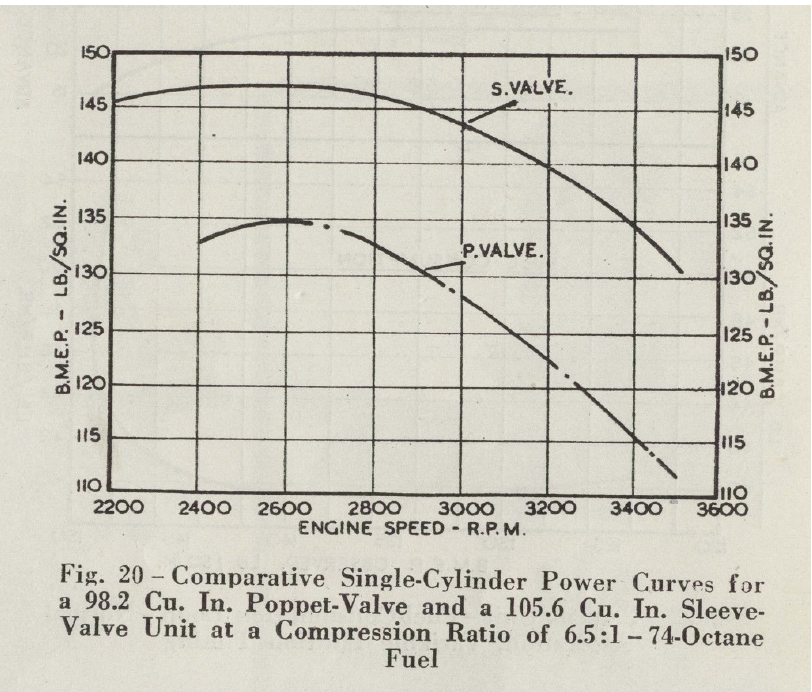
Figure A8. Comparison of an SVE to a poppet valve engine with 4 valves per cylinder, reproduced from Fedden (1938). Both engines operate naturally aspirated, and with the same compression ratio. Fedden is not concerned as to what portion of the BMEP advantage of the SVE is due to fMEP reduction, and what portion is due to volumetric efficiency effects, but at the low speed range, there cannot be any significant difference in volumetric efficiency.